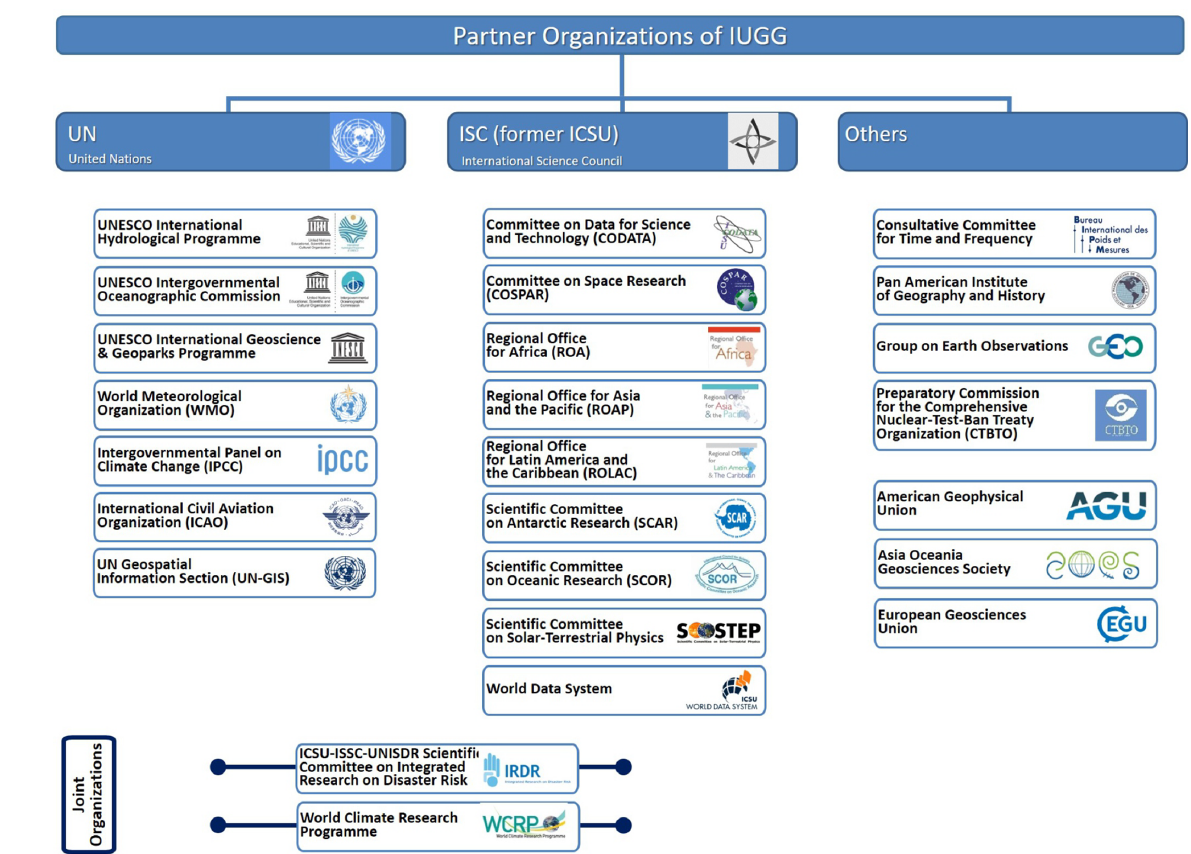
Figure 2. Scientific partner organizations (designed by F.